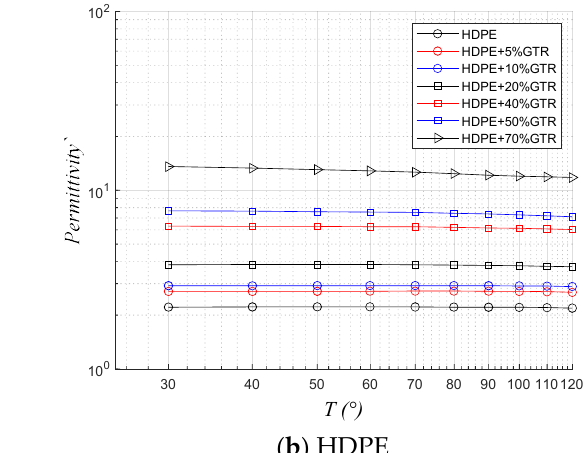
Figure 6. Frequency dependence response of imaginary permittivity, at 30 °C of ( a ) LDPE/GTR compounds and ( b ) HDPE/GTR compounds.